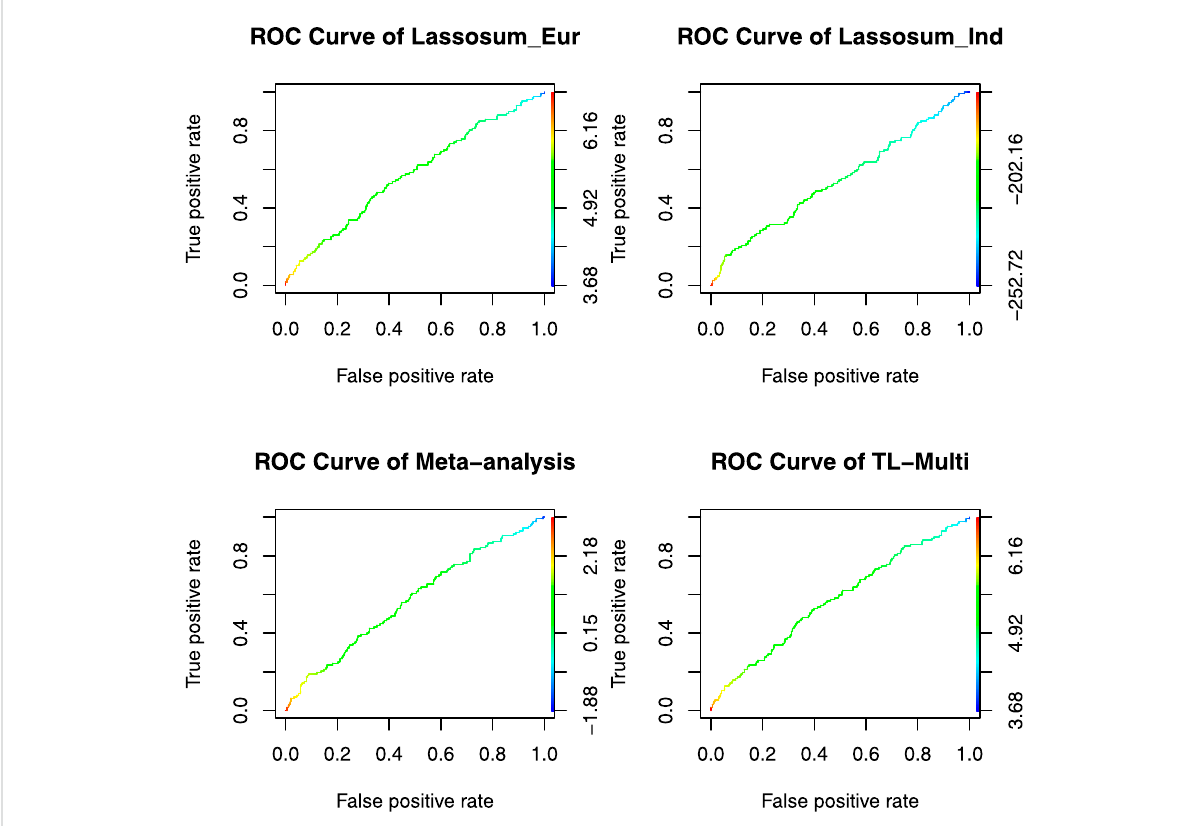
FIGURE 4 Receiver operating characteristic curve of Lassosum, meta-analysis, and TL-Multi in the analysis asthma study. Lassosum_Ind is Lassosum for the Indian population, and Lassosum_Eur is Lassosum for the European population. The corresponding AUC values with the optimal PRS of Lassosum for the Indian population and European population, meta-analysis, and TL-Multi are 0.5657, 0.5441, 0.5705, and 0.5721, respectively.